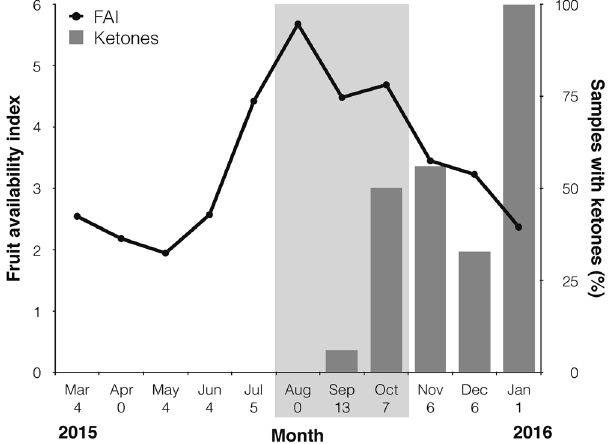
Figure 5. Urine samples testing positive for ketones (bars) in relation to fruit availability (line) across the study period. Monthly sample sizes are indicated on the x-axis. Light grey rectangle indicates the smoke